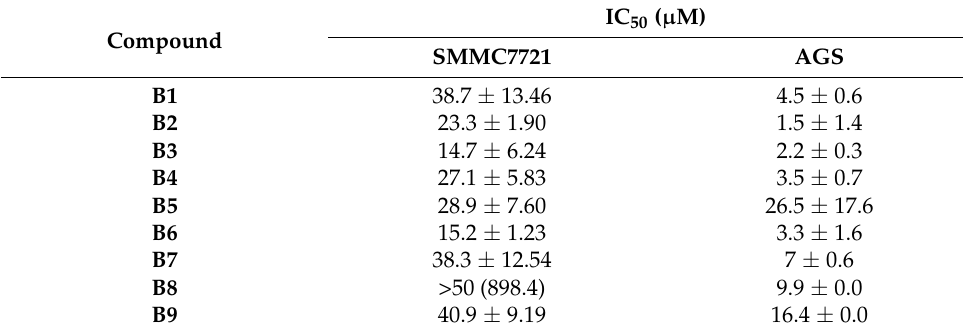
Table 3. Antiproliferative activities (IC 50 , µ M) of compounds B1–B9 on SMMC7721 and AGS cells for 48